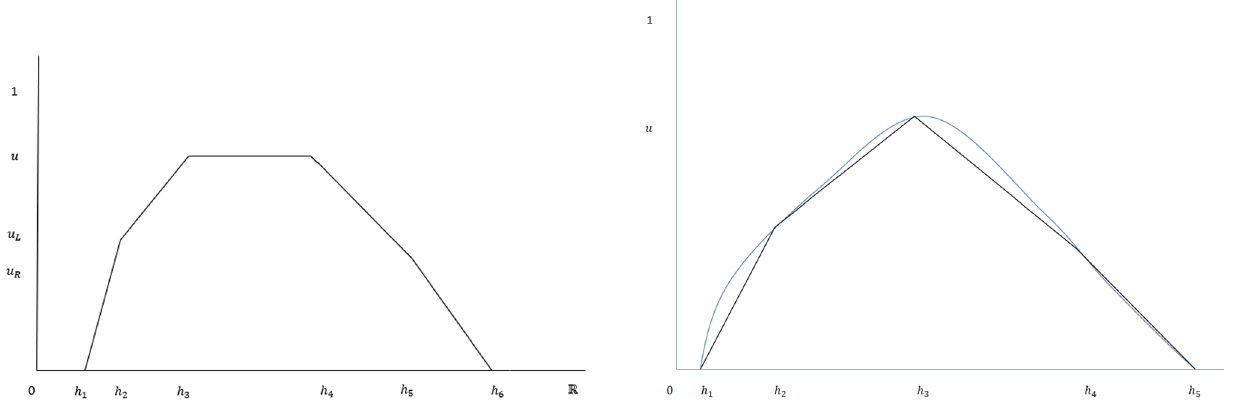
Fig. 4 Nonlinear fuzzy number approximated by